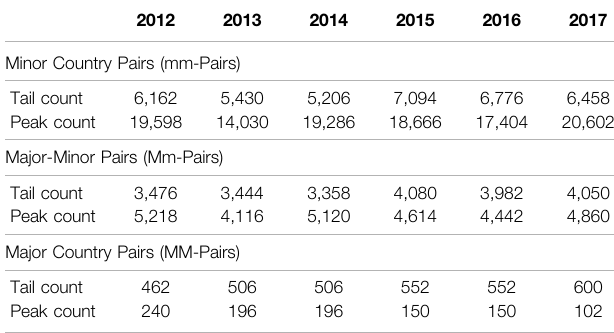
TABLE 2 | Value distribution of different country